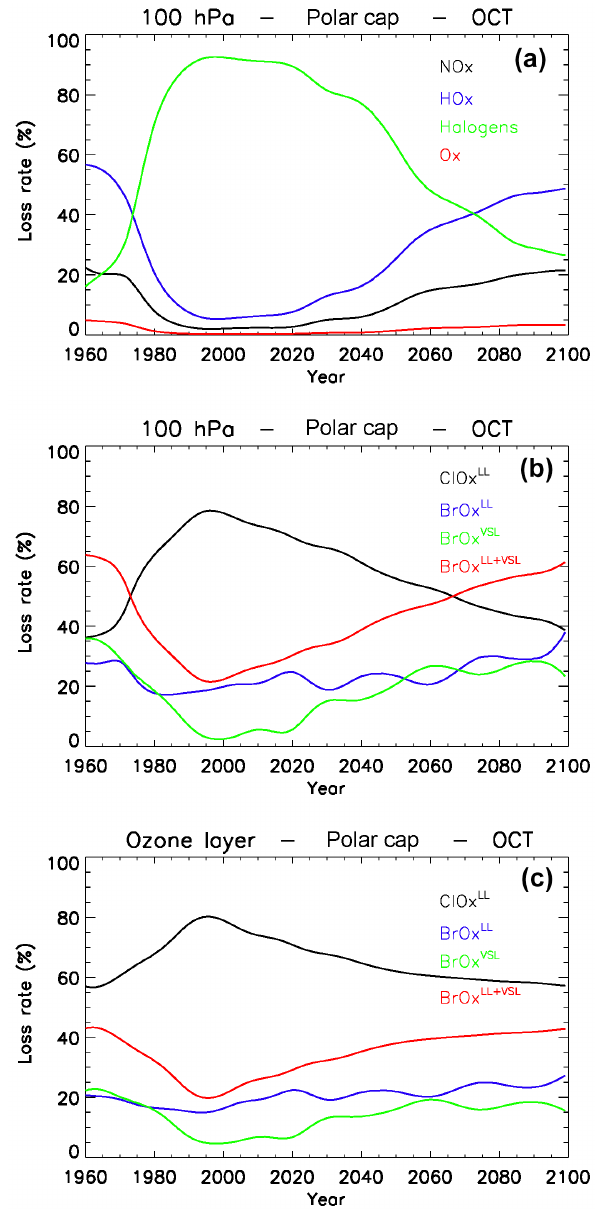
Figure 9. Temporal evolution of the October mean odd-oxygen loss rates within the southern polar cap. (a) Percentage contribution of each ozone depleting family (HO x , NO x , O x and Halogens) in re- spect to the total loss rate at 100hPa ( ∼ 15km), (b) percentage contribution of each halogen family (ClO x , BrO LL x , BrO VSL x and BrO LL + VSL x ) in respect to the whole halogen loss rate at 100hPa and (c) The same as panel (b) but vertically integrated within the lower stratosphere (i.e. in-between the white lines shown in Fig. 6). Ensemble mean values are